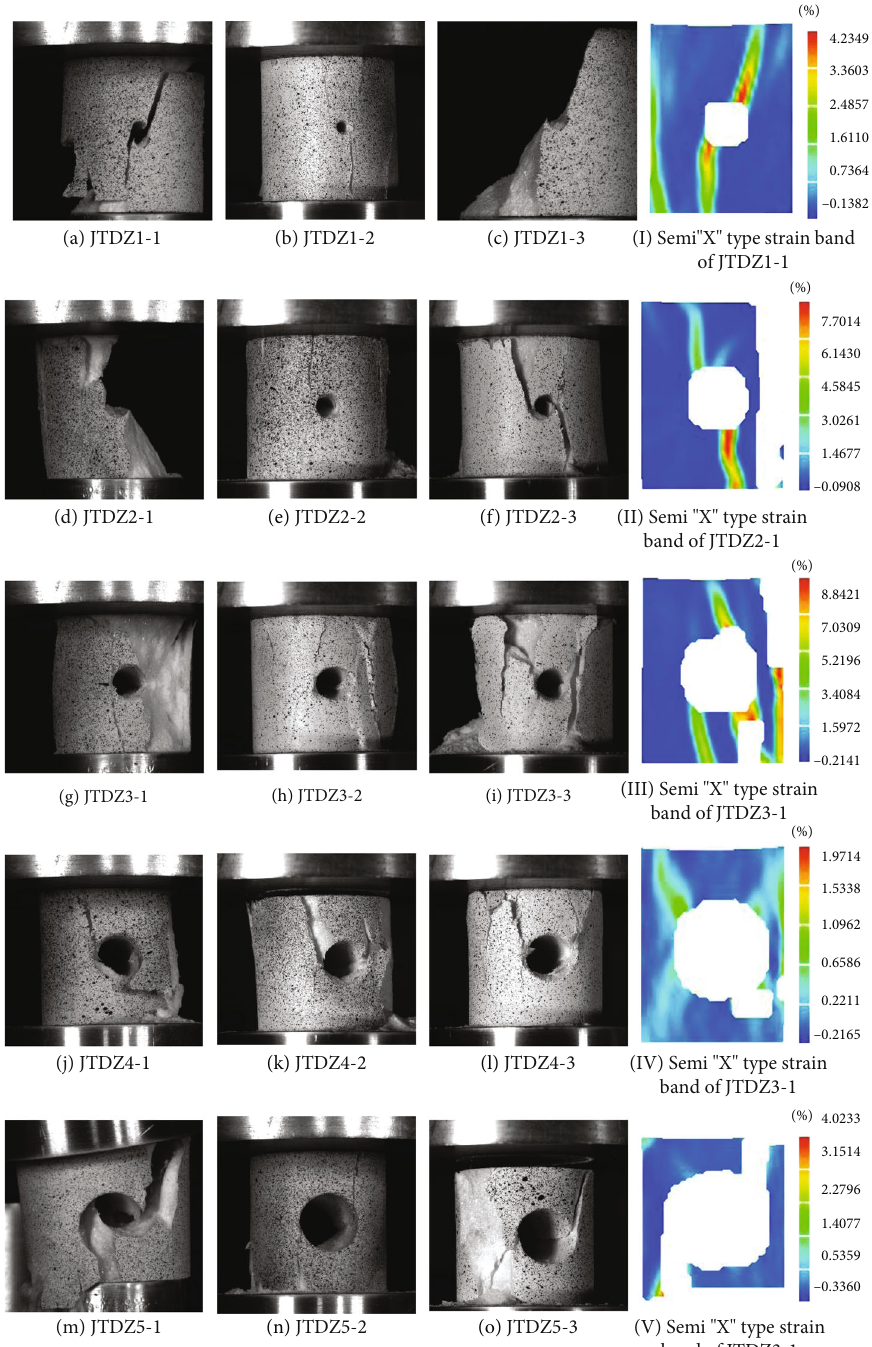
Figure 3: Failure characteristic diagram and x -direction strain cloud diagram of uniaxial compression specimen with circular